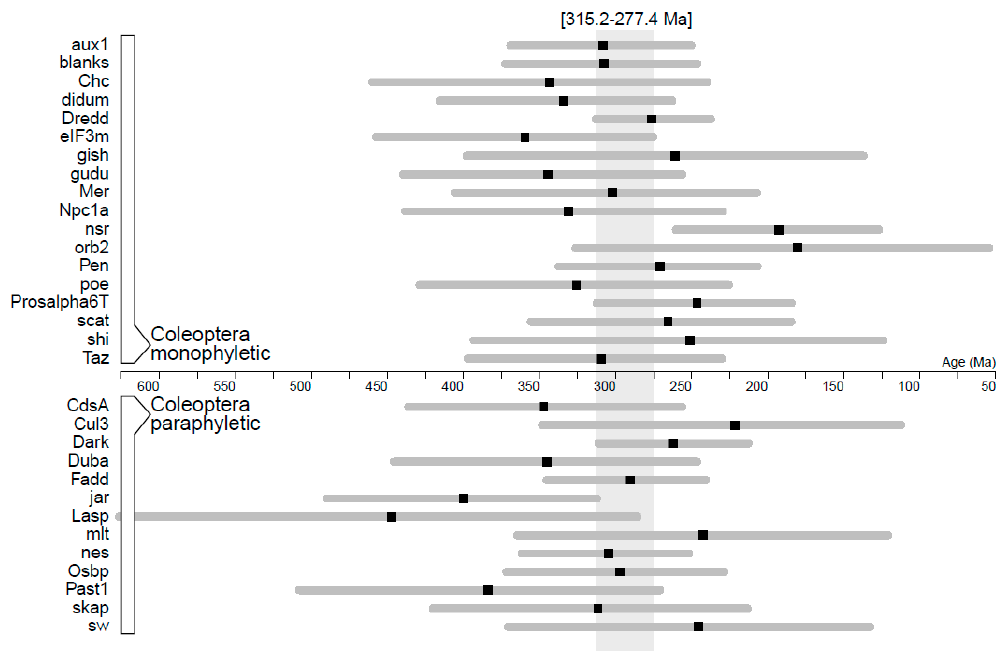
Figure 5. Inferred ages and 95% credibility intervals for the Coleoptera clade (top panel) or a Coleoptera + Strepsiptera clade (bottom panel) based on the molecular clock analyses of amino acid sequence data of sperm individualization genes. The full overlap of age estimates of monophyletic Coleoptera identifies an interval (shaded area) consistent with the proposed age of the group based on fossil data and used here as age prior for the evolutionary rate analyses in beetles. Table 4. Characteristics of amino acid datasets of sperm individualization proteins of insects deduced from information in public databases (B: unbiased [0] and sex-biased [1] genes; N: non-interacting [0] and interacting [1]), as well as information deduced from their phylogenetic analyses, including duplications (D: single [0] and multicopy [1]), evolutionary rates, evolutionary rate heterogeneity (ucld.stdev), and the estimated age of the clade Coleoptera. Gene B/D/N Substitution Rate (×10 − 3 ) ucld.stdev